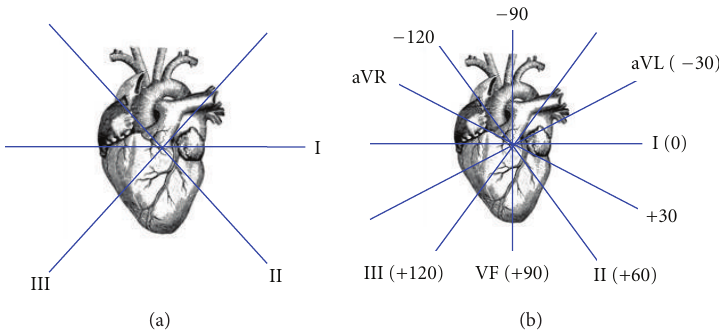
Figure 1: The first three leads of ECG devised by Einthoven constitute the Einthoven triangle [1]. Lead I is used as the reference lead and is located at 0 degrees. Positive designations increase by 30 degree increments in a clockwise direction to 180 degrees. Lead II appears at 60 degrees. Augmented limb leads (aVL, aVR, aVF) are unipolar limb leads, containing only a positive pole. aVL is designated at − 30 degrees, aVF at 90 degrees, and lead aVR at − 150 degrees.